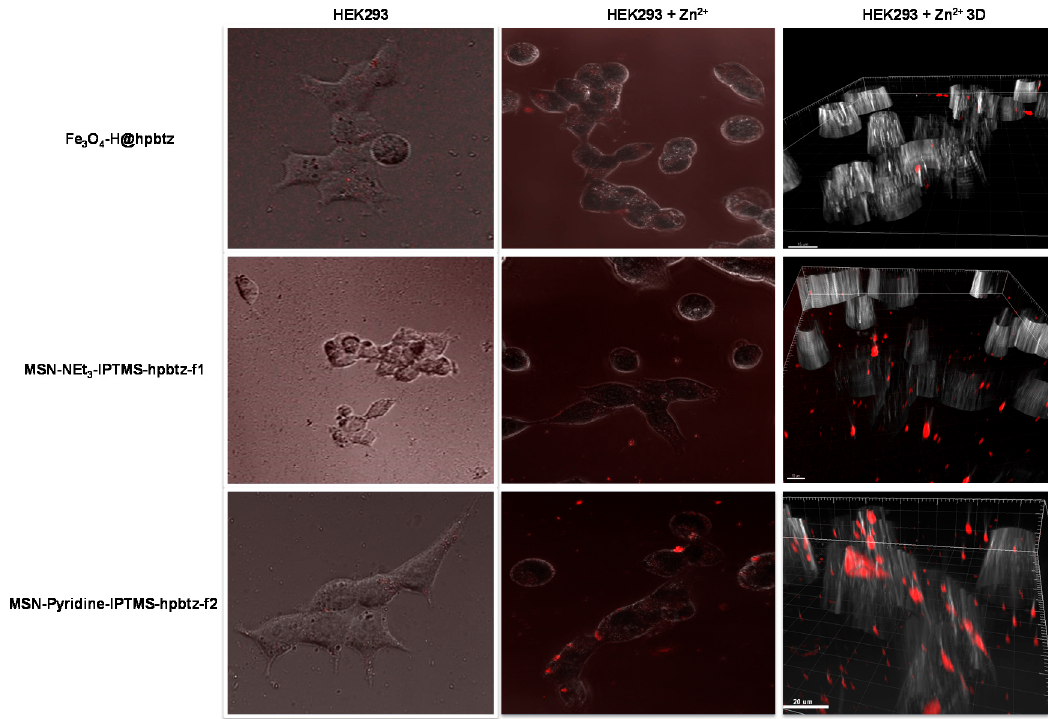
Figure 17. Fluorescence images of the HEK293 cells treated with different functionalized materials in absence of Zn 2+ supplementation (Column I), in the presence of supplemented Zn 2+ (Column II) and 3D reconstruction of cells treated with nanomaterials in the presence of Zn 2+ (Column III).